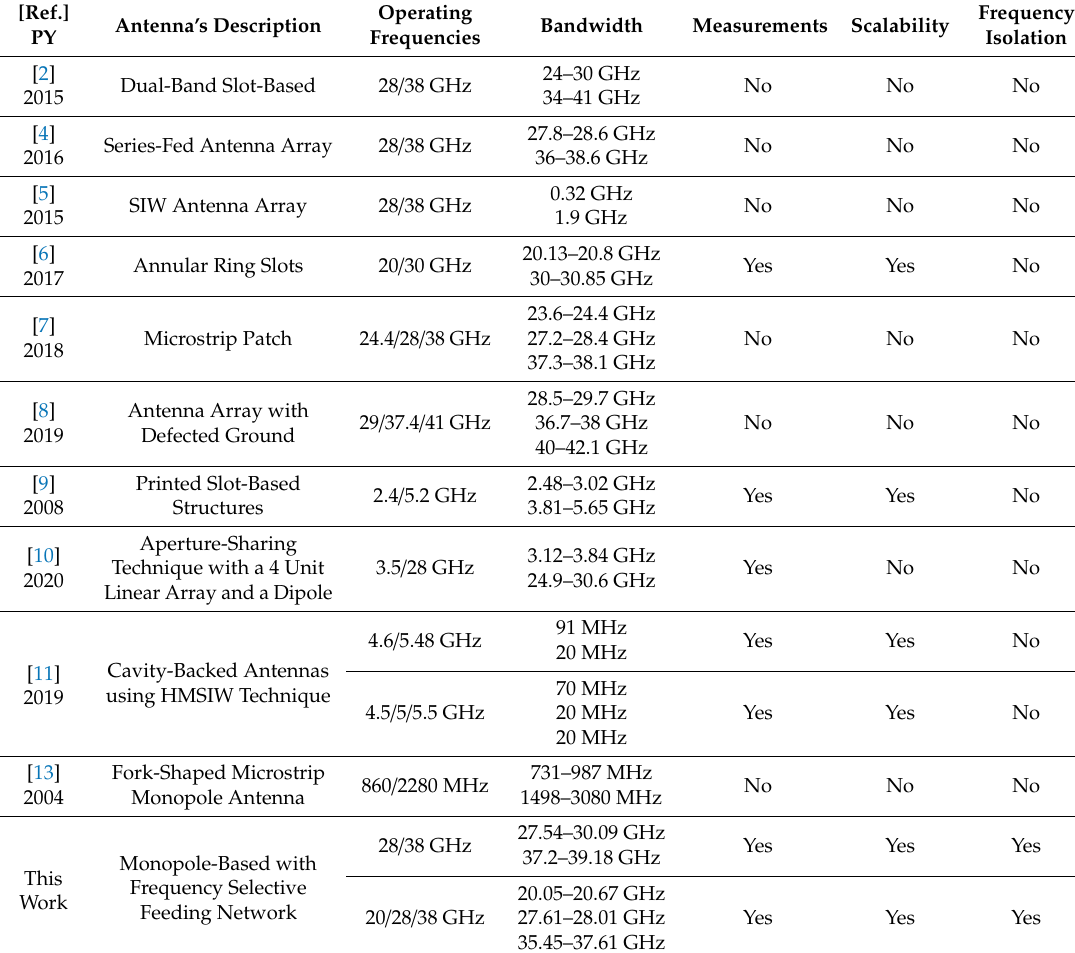
Table 5. State-of-the-Art of Multi-Band Antennas: Main Results.